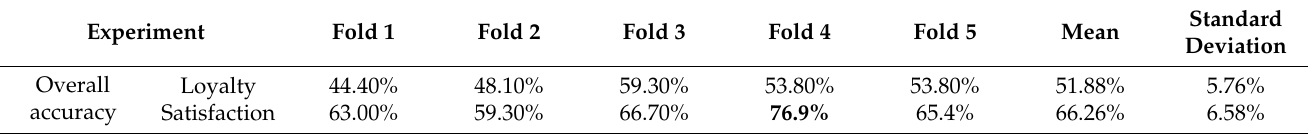
Table 6. Results of fivefold cross-validation experiments in the DT model.